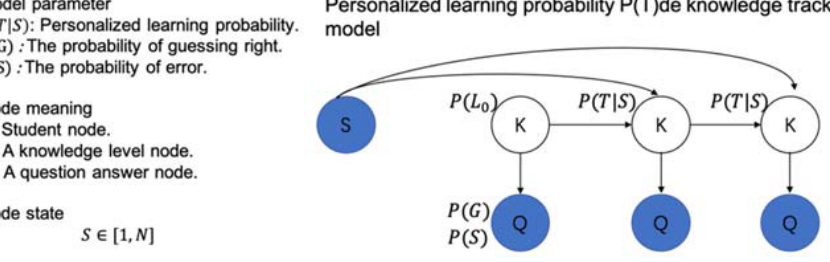
Figure 7. KT model of personalized learning probability.